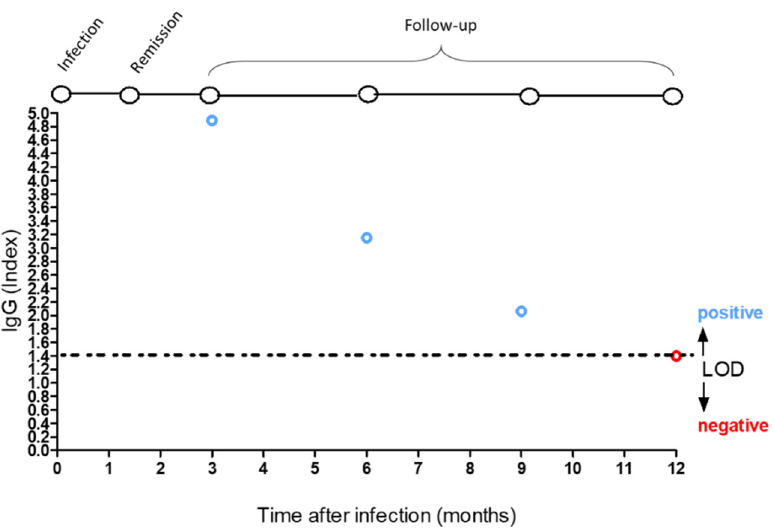
Figure 2. Positive IgG index (blue circles) and negative IgG index value (red circles). Limit of detection (LOD) index equal to 1.4.